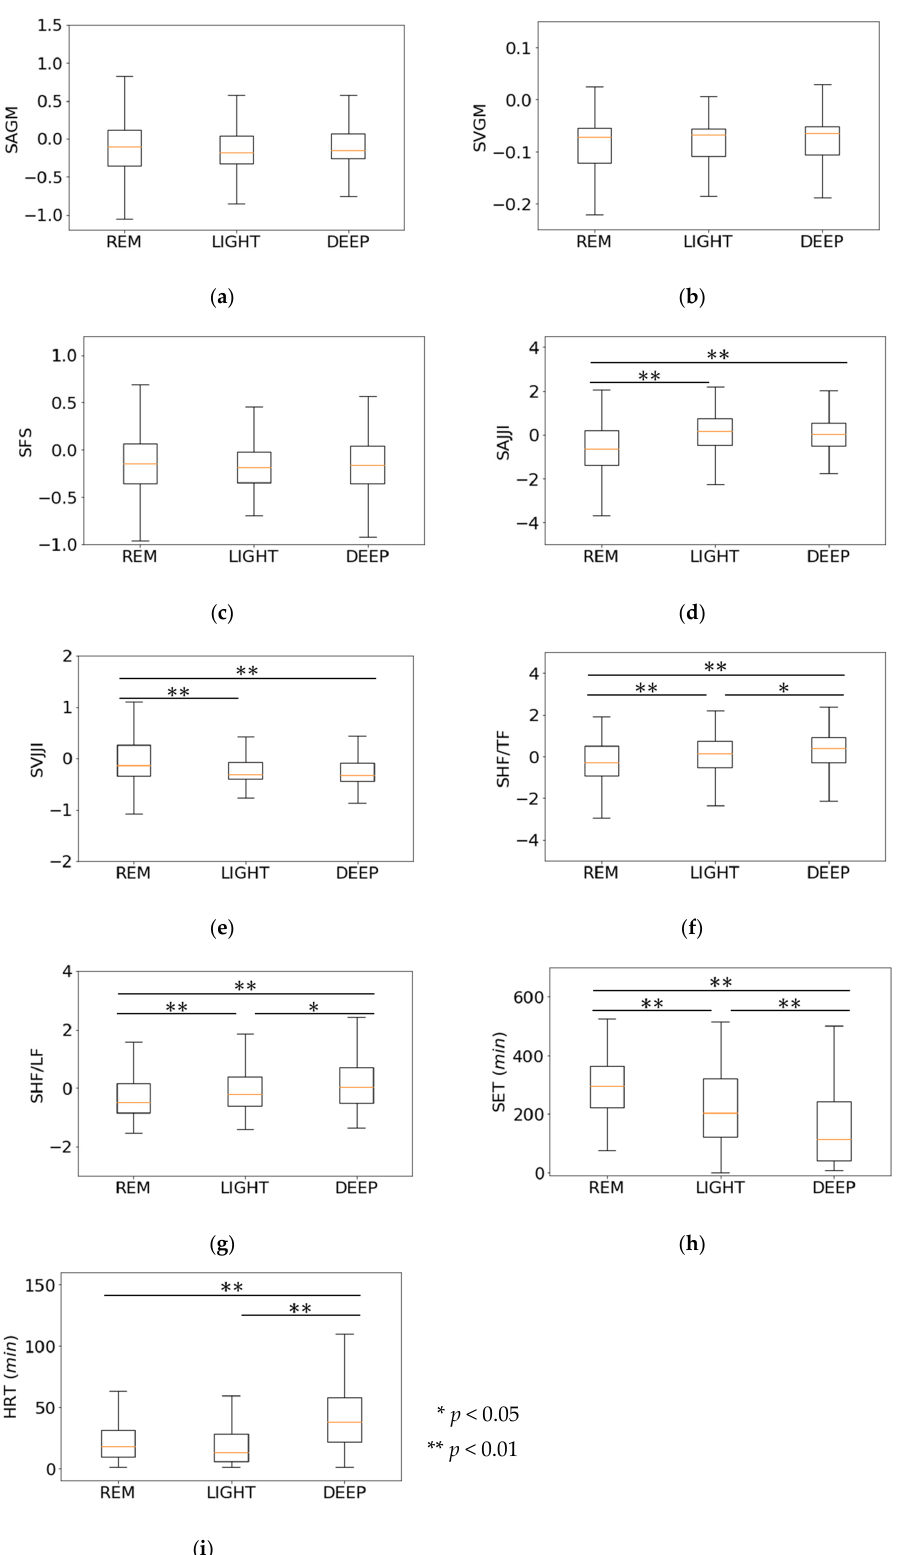
Figure 9. Wilcoxon signed-rank test results for first-step features: ( a ) Standardized average of gross movements; ( b ) Standardized variance of gross movements; ( c ) Standardized full spectrum; ( d ) Standardized average of JJI; ( e ) Standardized variance of JJI; ( f ) Standardized HF/TF; ( g ) Standardized HF/LF; ( h ) Sleep elapsed time; ( i ) Head rest time.